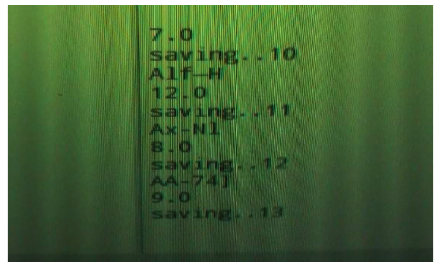
Figure 5: Showing captured plate